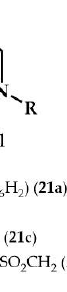
Table 5. Hydroamination of phenylacetylene with aniline .